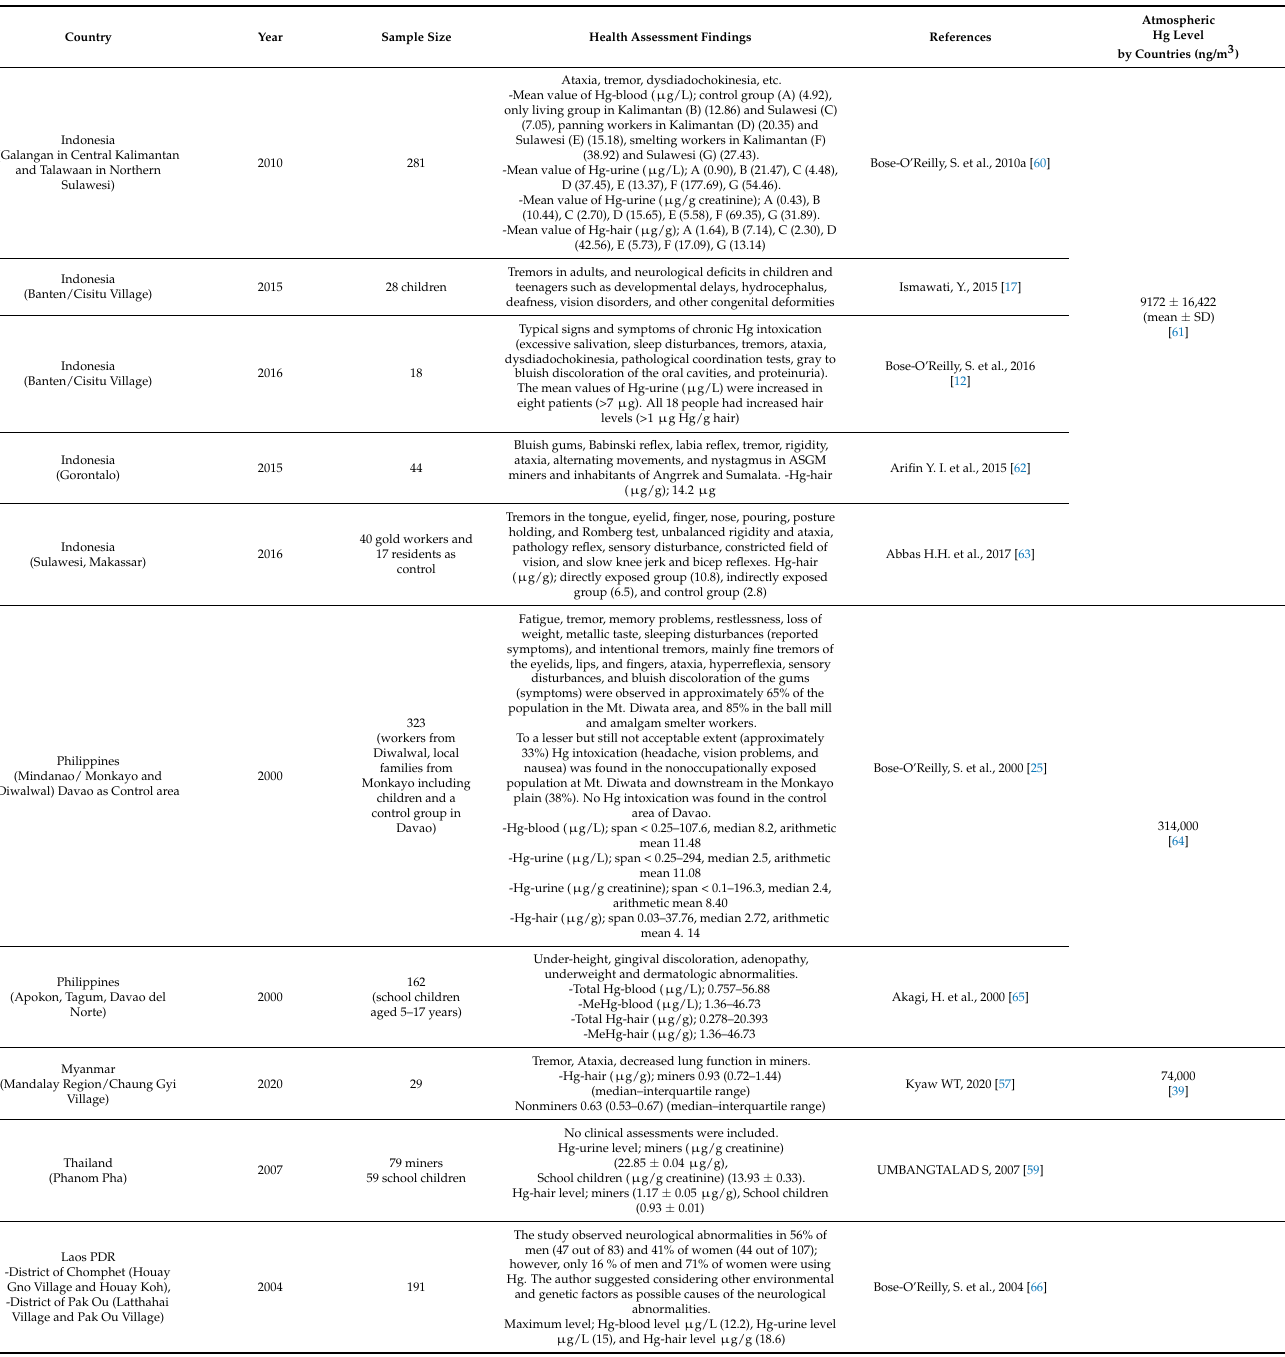
Table 1. Health assessment findings in SEA countries and Hg contamination